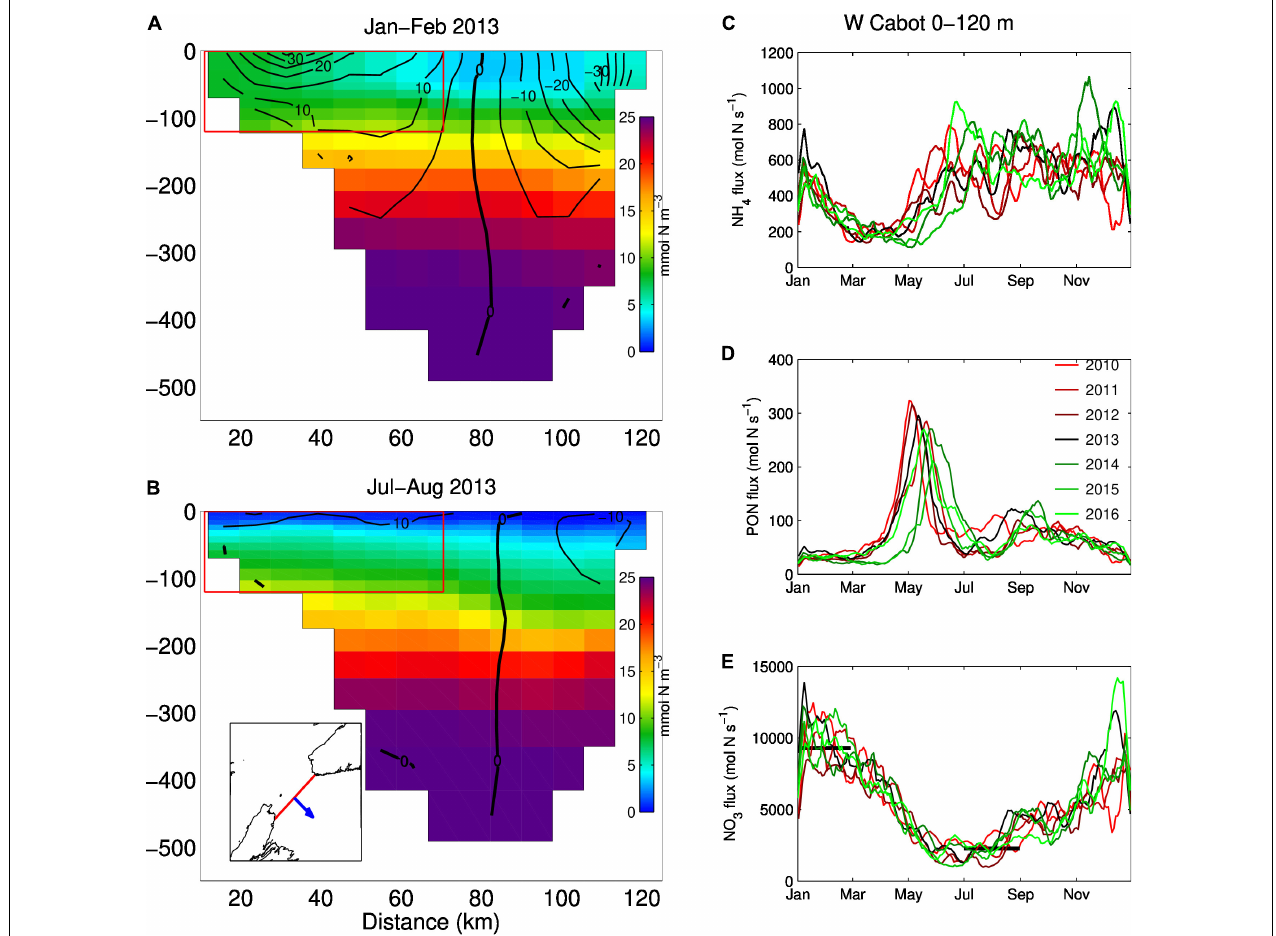
FIGURE 7 | Mean nitrate concentrations (mmol N m − 3 , background color) across the Cabot Strait section for (A) January and February, and (B) July and August 2013. The black lines represent the mean simulated velocities (cm s − 1 ) for the same months. The panels to the right show the mean transport through the western half of Cabot Strait (red box depicted in panels A and B ) over the 0–120 m depth range for (C) ammonium (NH 4 ), (D) particulate organic nitrogen (PON) and (E) nitrate (NO 3 − ). A positive value denotes an outflow. The black horizontal bars in panel E represent the mean nitrate transport estimated by Petrie and Yeats (2000) on the western side of Cabot Strait for depths of 0–150